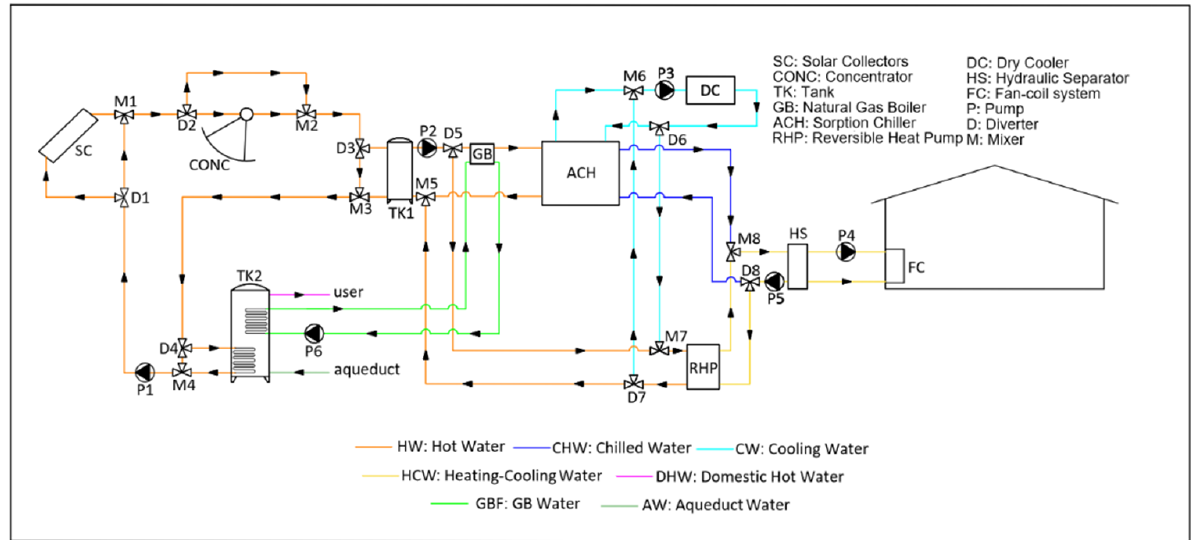
Figure 2. Layout of the analyzed hybrid SHC system.